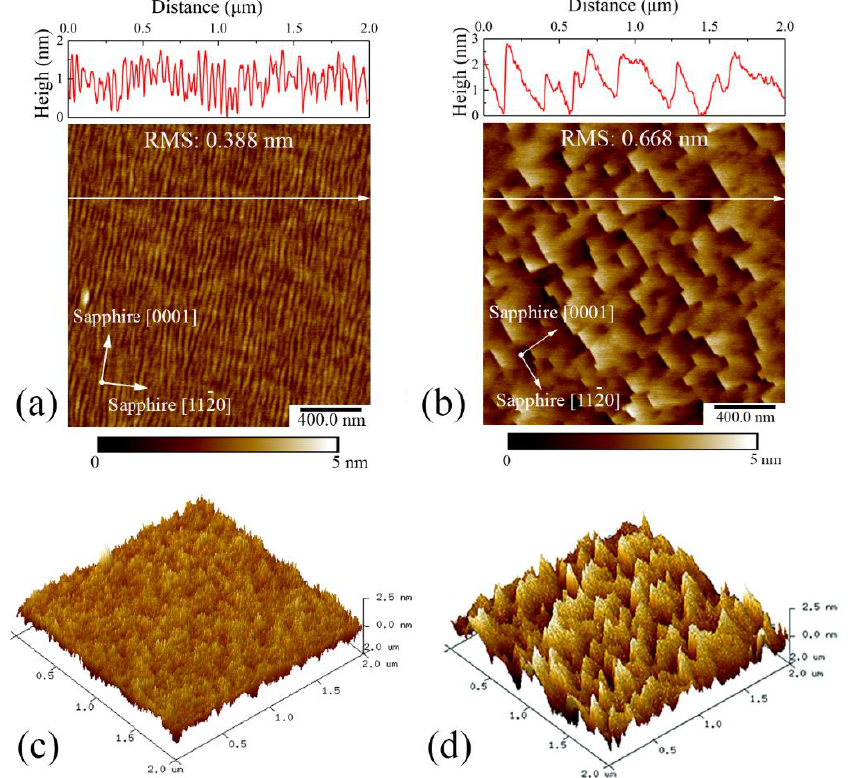
Figure 8. Top and 3D-viewed AFM images of ( a , c ) as grown and ( b , d ) 5-h annealed AlN samples. The AlN thickness is 500 nm. The AlN thickness is 500